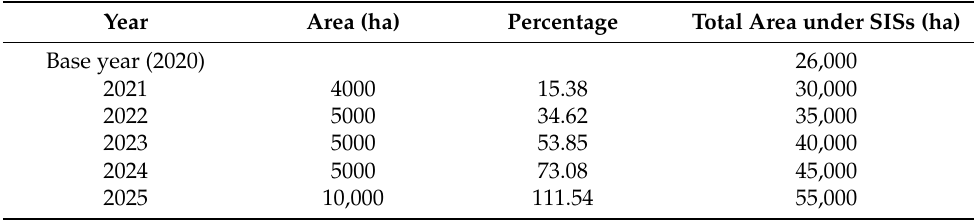
Table 2. Proposed smallholder irrigation development from 2021 to 2025.